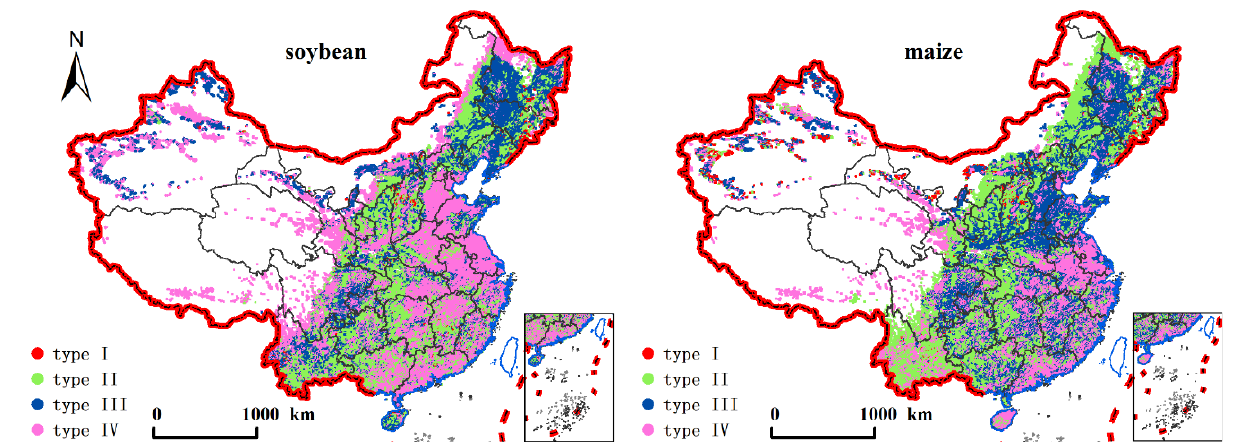
Figure 3. Soybean and maize yield efficiency advantage type zoning diagram in China.